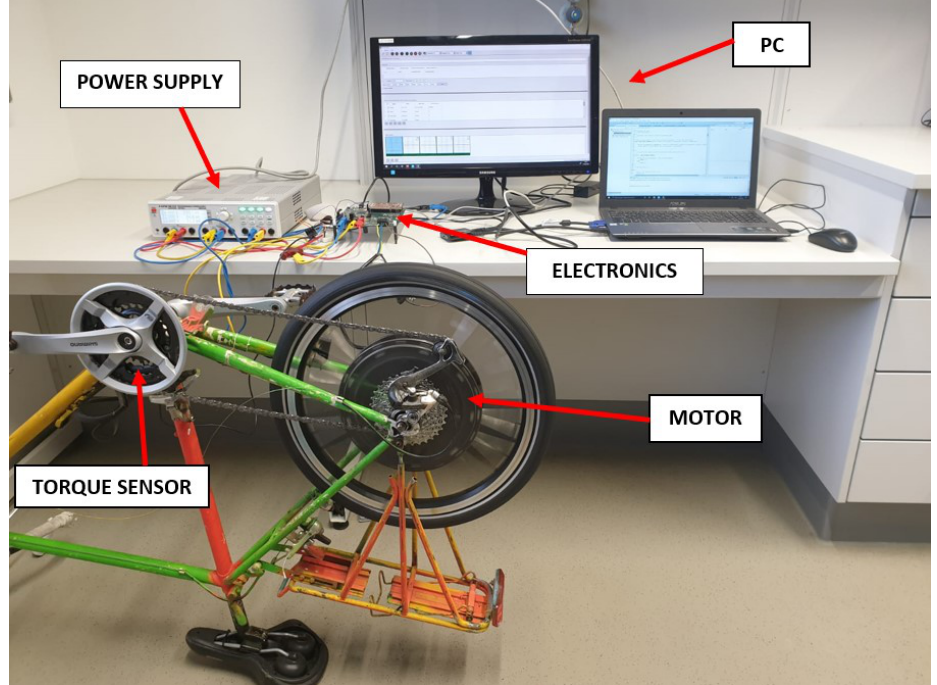
Figure 5. Setup used for the experimental validation.